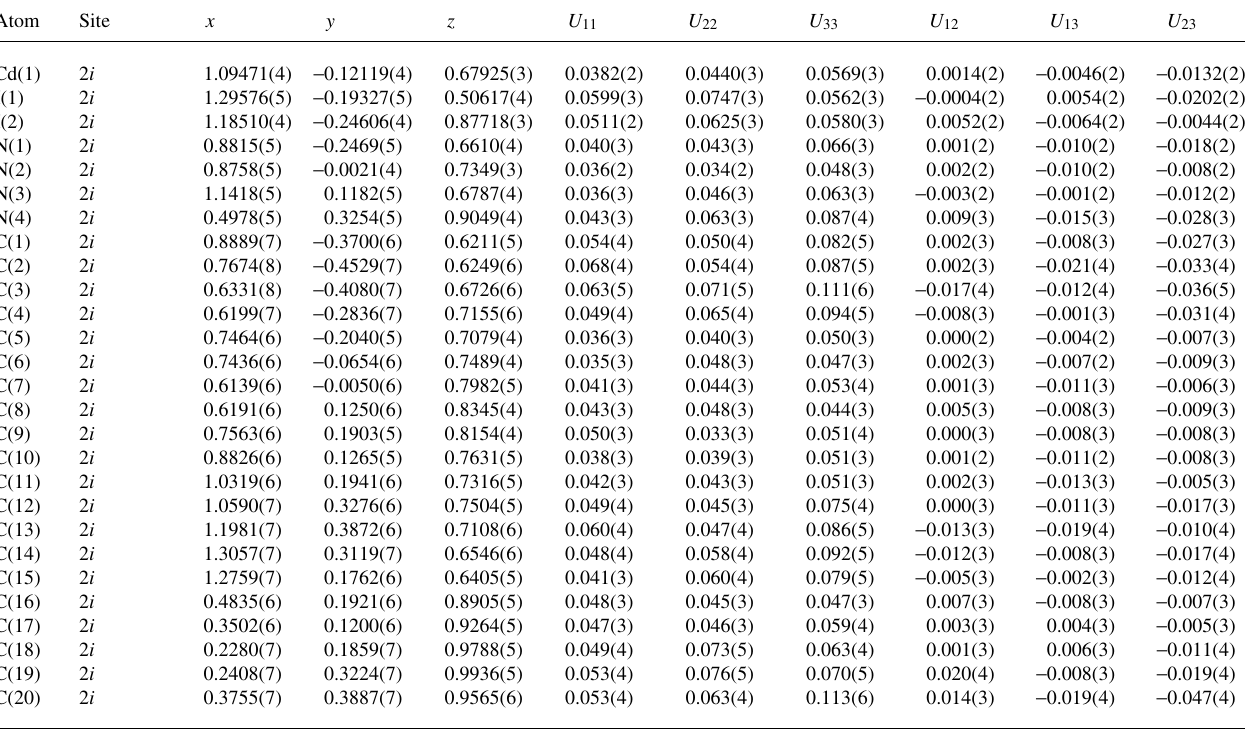
Table 3. Atomic coordinates and displacement parameters (in Å 2 )